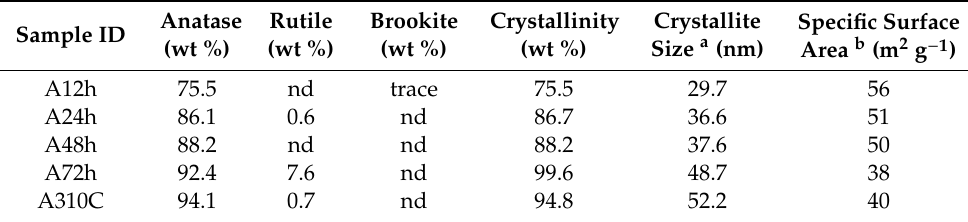
Figure 1. X-ray di ff raction (XRD) patterns of TiO 2 nanoparticles (NPs) treated hydrothermally at 250 ◦ C for 12 h, 24 h, 48 h, and 72 h. A310C (red line) was prepared at 310 ◦ C for 24 h. Characteristic XRD peaks of anatase (A), rutile (R), or brookite (B) are indexed. Table 1. Crystal phase composition and average crystallite size of anatase and BET surface areas for TiO 2 NPs treated